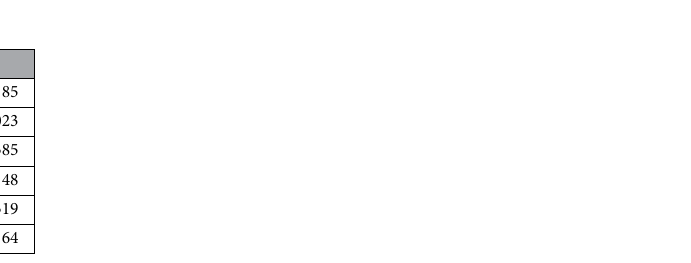
Table 6. R 2 and Q 2 values. Source: Adapted from Hair et al. 87 and data